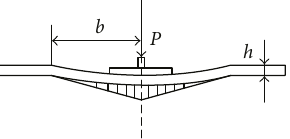
Figure 1: A schematic diagram of rigid pavement carrying